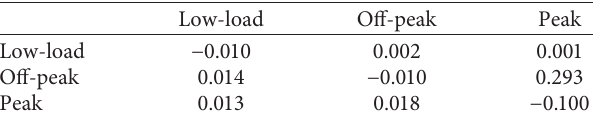
Table 2: Self- and cross-elasticity factors for LS.